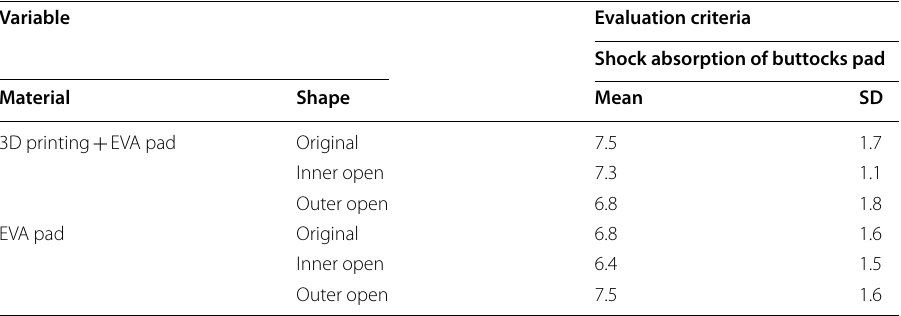
Table 9 Mean and SD of subjective comfort depending on material and shape (N